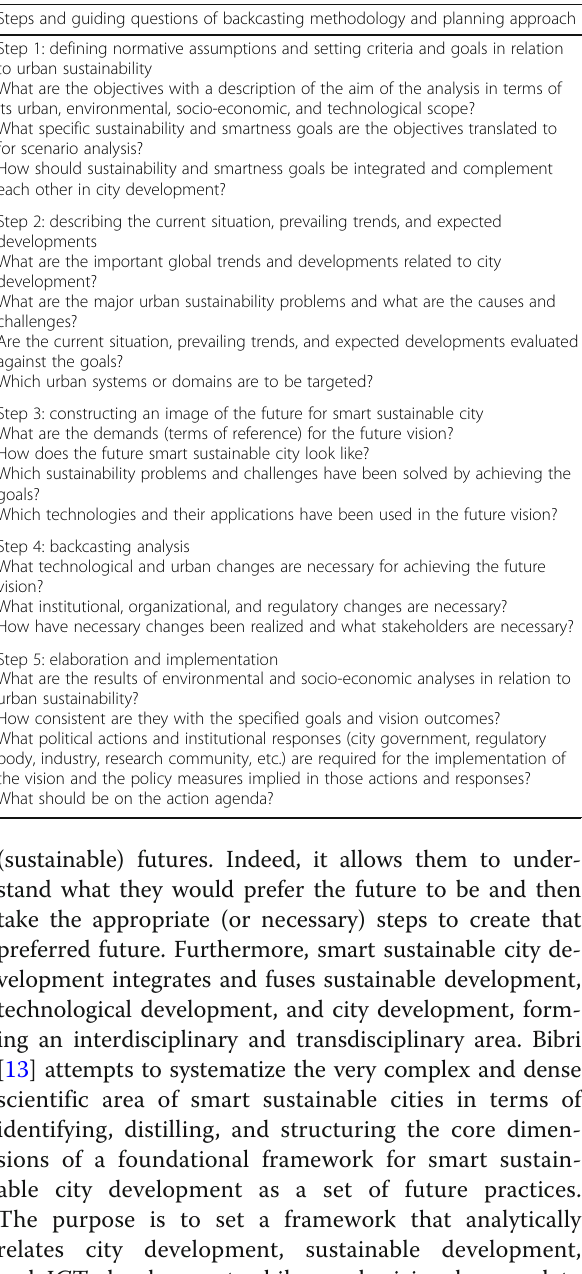
Table 4 Steps and guiding questions of backcasting methodology and planning